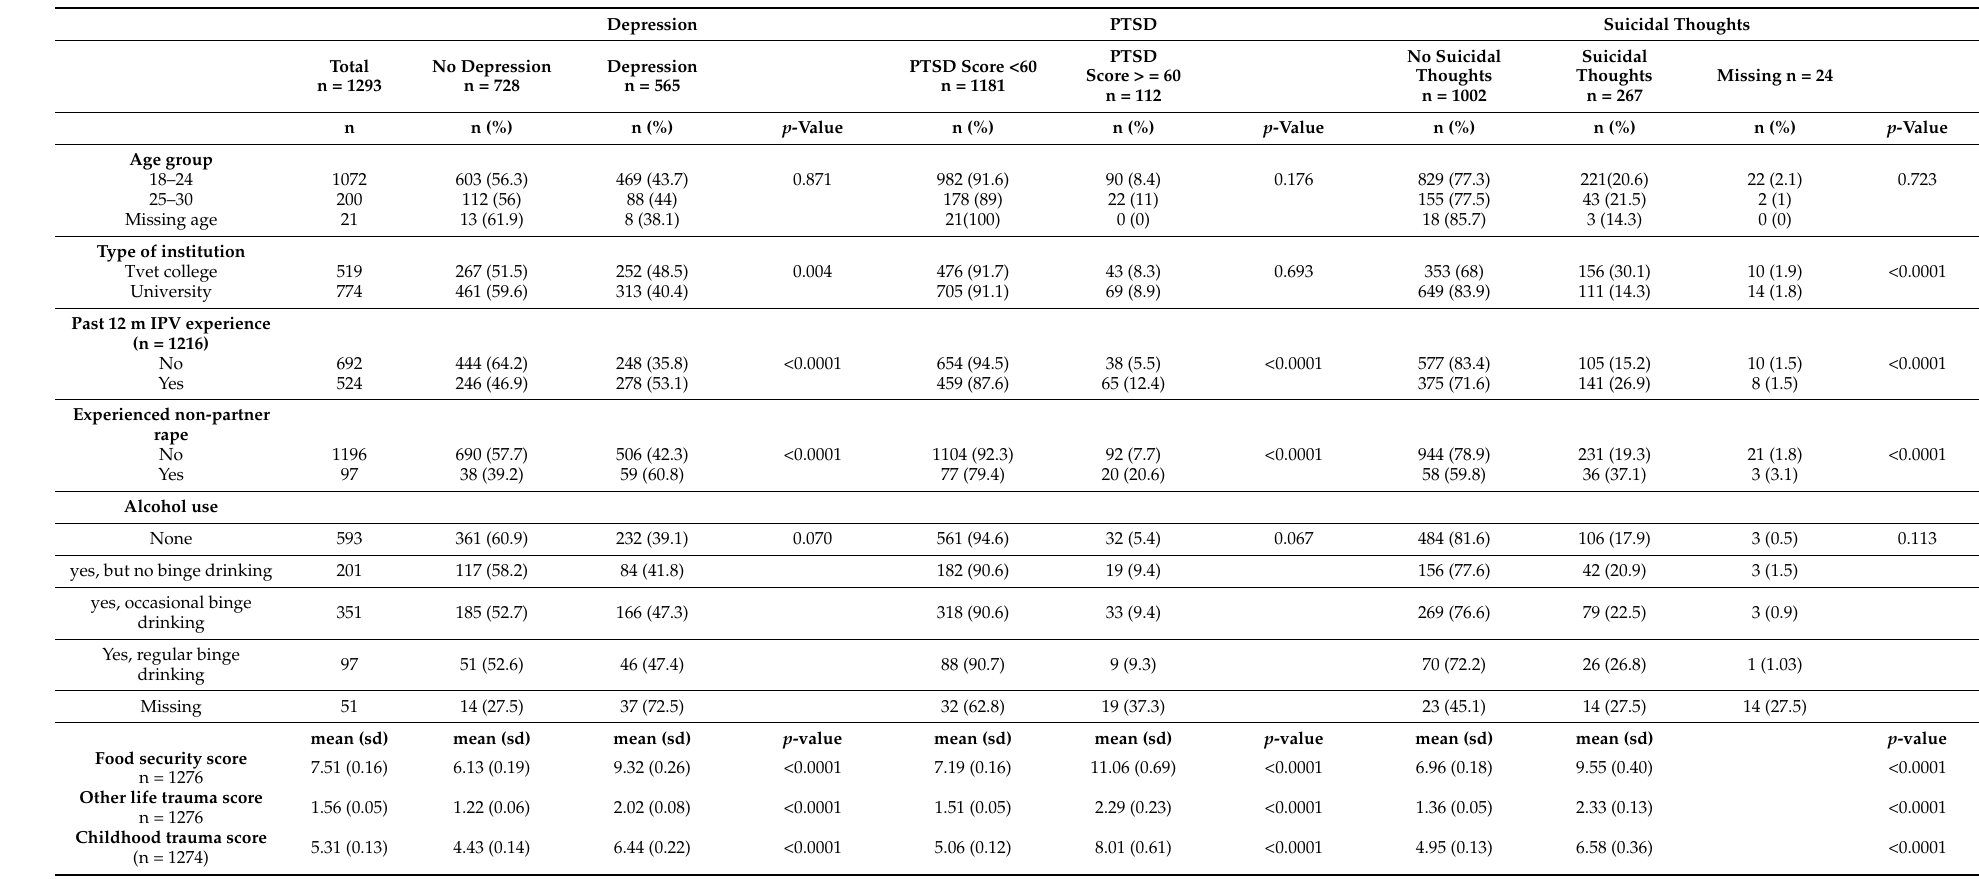
Table 2. Prevalence of depression, PTSD, and suicidal thoughts disaggregated by